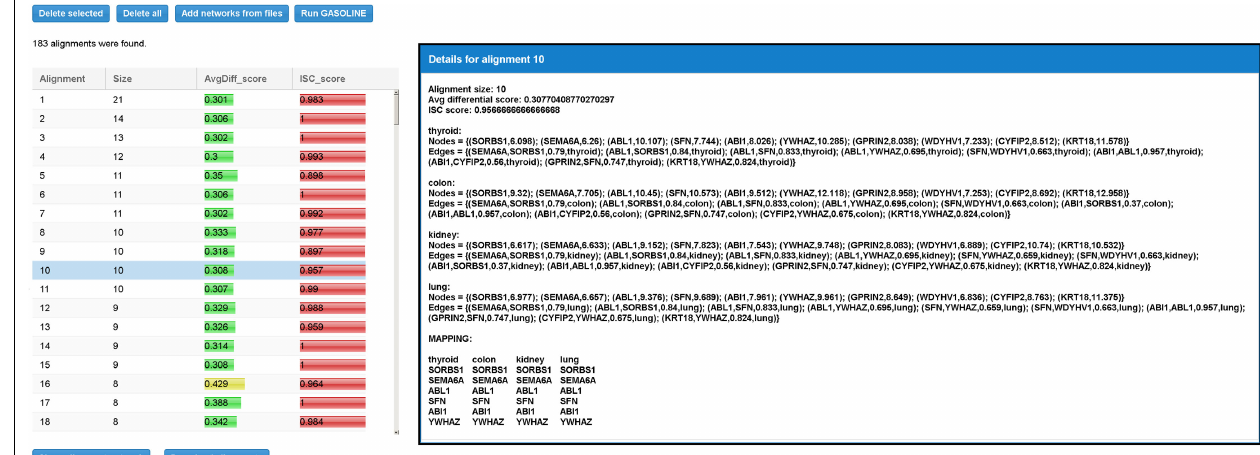
subnetworks (defined by the set of nodes and edges) and the mapping between aligned nodes. Nodes of aligned networks are represented by the corresponding ids, followed by their weights, while edges are represented by the ids of interacting proteins, followed by the interaction weights and the corresponding tissues. Alignment mapping is represented as a matrix where rows contain aligned proteins and columns represent nodes of the same